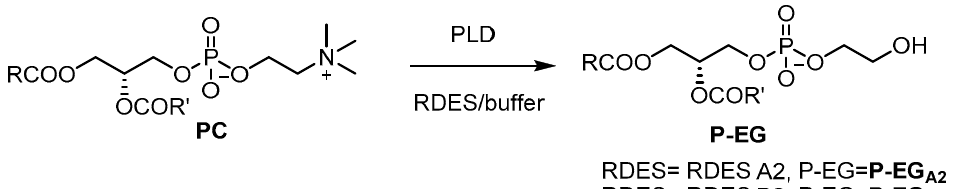
Figure 6. Scheme of transphosphatidylation reaction of PC to P-EG. Also in this case, as described in Section 2.3.1, most of the products precipitated and just a minor part ( ≈ 10%) was recovered by solvent extraction from the RDES/buffer medium. This confirmed again the efficacy of the process medium optimization in the modulation of the reagent and products solubility. 1 H NMR spectra of the final products are reported in Figure 7 (P-EG A2 , green line, and P-EG B2 blue line). As already observed in the PGs preparation in 2.2.1, when the reaction was performed in RDES containing ChCl, namely RDES A2, a small quantity of PC (~8%, value obtained by HPLC analysis) remained unreacted, whereas, in RDES B2 (BetG/EG 1:2), PC was completely converted to